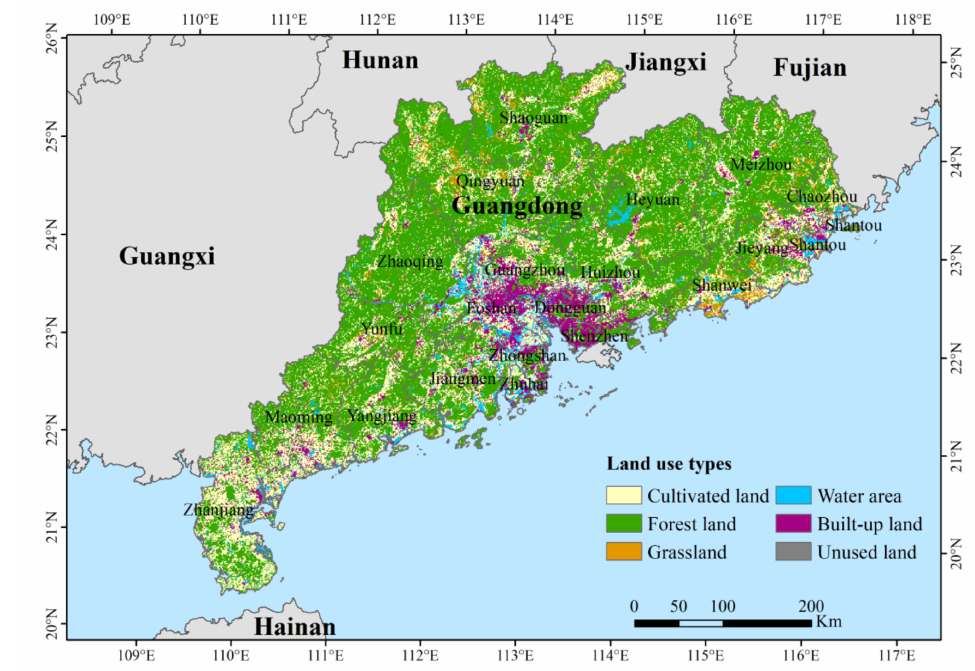
Figure 2. Land use of Guangdong province in